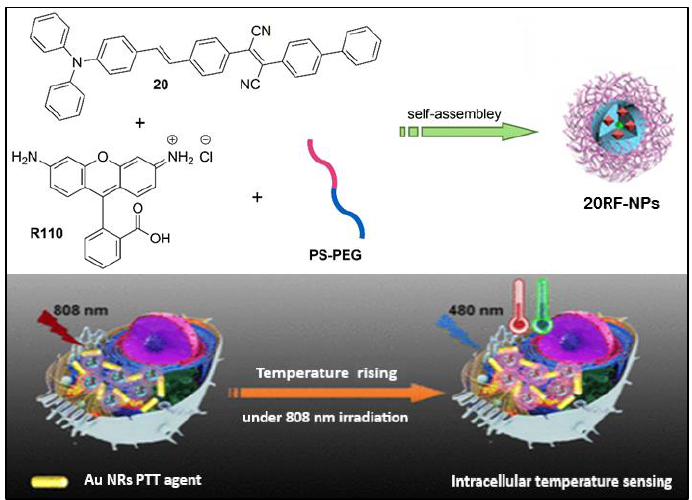
Figure 21. Self-assembly of probe 20 with Rhodamine 110 into amphiphilic polymer PS-PEG to form nanoparticles 20RF NPs and illustration of intracellular temperature sensing. Adapted with permission from [87]. Copyright (2020) American Chemical Society.